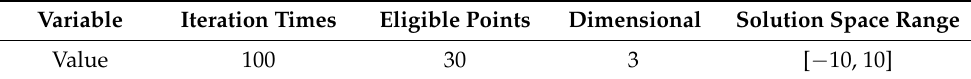
Table 4. CGO initialisation value.